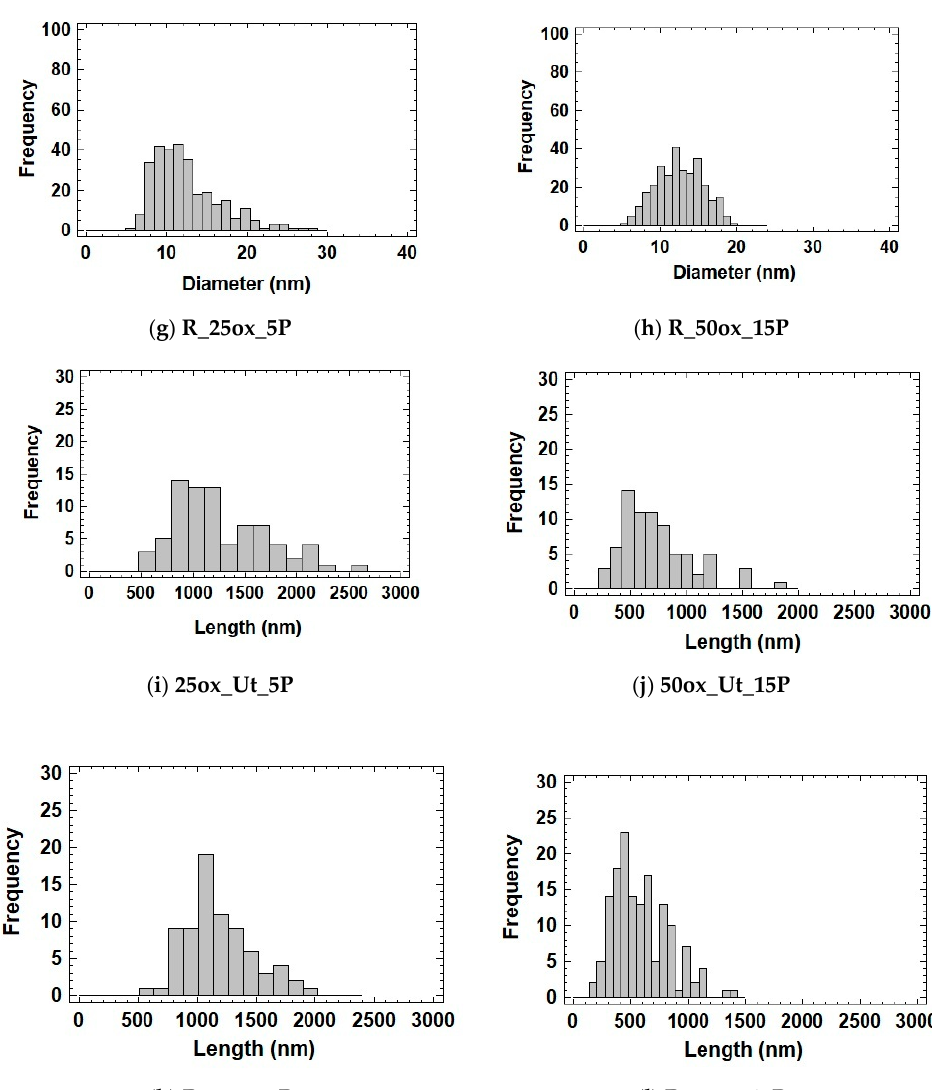
Figure 4. TEM images of ( a ) 25ox_Ut_5P, ( b ) 50ox_Ut_15P, ( c ) R_25ox_5P and ( d ) R_50ox_15P of CMNF. Distribution of diameter ( e–h ) and length ( i–l ).